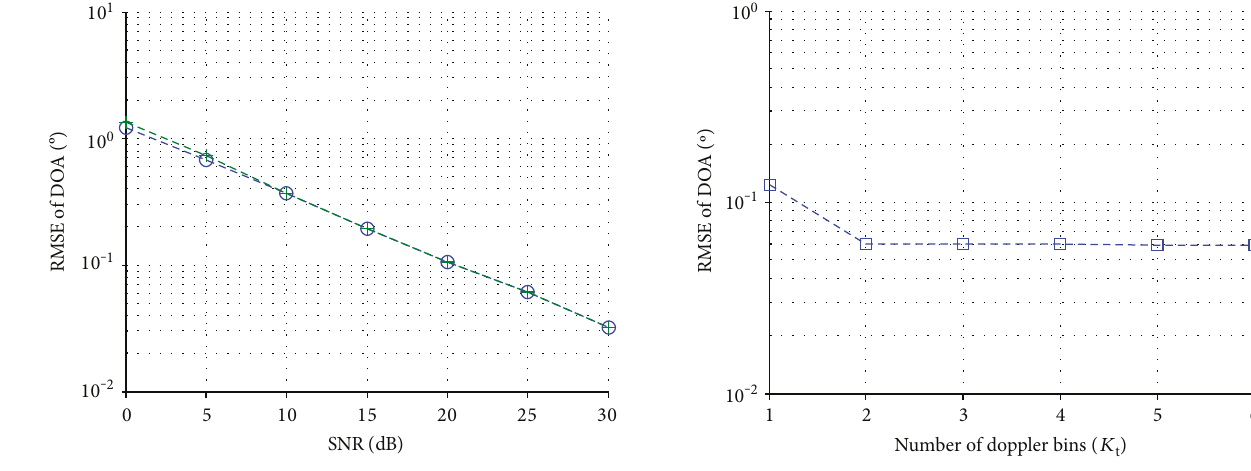
Figure 3: E ff ect of the number of Doppler bins on the DOA estimation